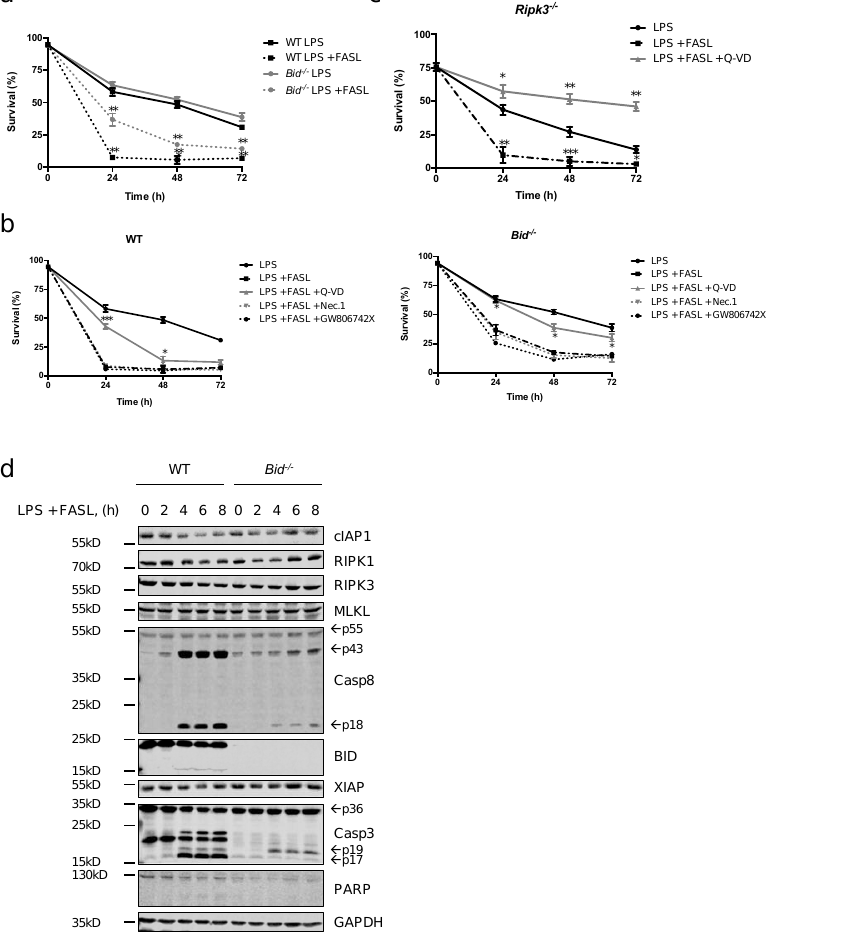
Figure 4. LPS-primed neutrophils remain sensitive to FASL killing. ( a ) Primary WT and Bid −/− neutrophils were primed with LPS (10 ng/mL) for 30 min prior to stimulation with FASL (100 ng/mL) for indicated time points. Viability was assessed by flow cytometry. n ≥ 3, mean ± SEM. ( b ) Primary WT and Bid −/− neutrophils were primed with LPS (10 ng/mL) for 30 min, pre-treated with either Q-VD-OPh (20 μ M), Nec.1 (20 μ M) or the mouse MLKL inhibitor GW806742X (1 μ M) for 30 min followed by stimulation with FASL (100 ng/mL) for indicated time points. Viability was assessed by flow cytometry. n = 3, mean ± SEM. ( c ) In vitro differentiated Ripk3 −/− neutrophils were primed with LPS (10 ng/mL) for 30 min prior to stimulation with FASL (100 ng/mL) with or without Q-VD-OPh (20 μ M) for indicated time points. Viability was assessed by flow cytometry. n ≥ 3, mean ± SEM. ( a – c ): p < 0.05 (*), p < 0.01 (**), p < 0.005 (***) and p < 0.001 (****). ( d ) In vitro differentiated WT and Bid −/− neutrophils were primed with LPS (10 ng/mL) prior to stimulation with FASL (100 ng/mL) for 0–8 h. Lysates were subjected to immunoblot. Presented immunoblots are representative of at least two independent